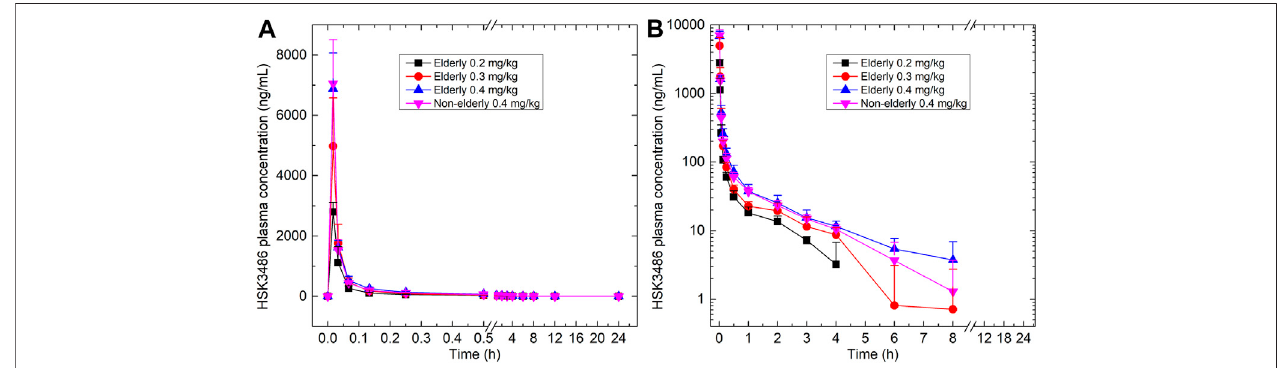
FIGURE 3 | Plasma concentration-time curves for HSK3486 in (A) linear scale; and (B) semi-log scale. Data are reported as mean + standard deviation.